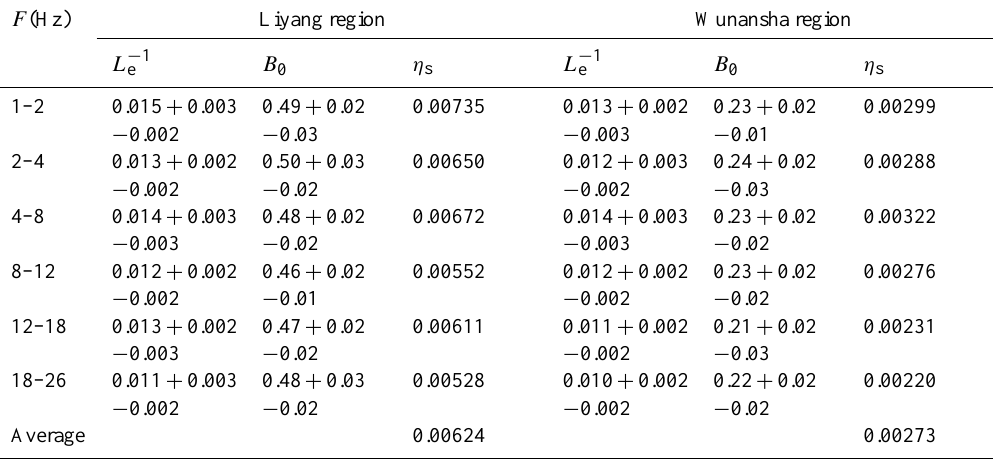
Table 1. Calculated results of seismic albedo B 0 , inverse of extinction length L − 1 e and scattering coefficients η s in the Liyang and Wunansha regions.